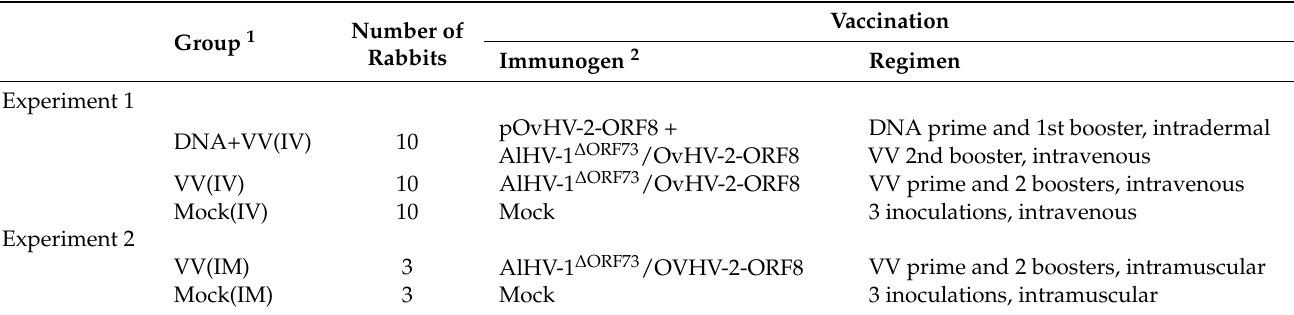
Table 1. Immunogens and vaccination platforms tested in this